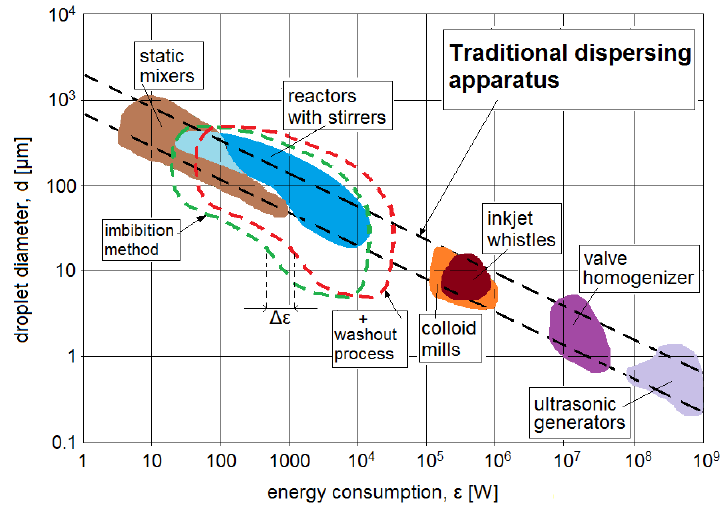
Figure 7. Dependence of droplet diameter on energy demand for different traditional emulsification methods [46] versus using the imbibition method.